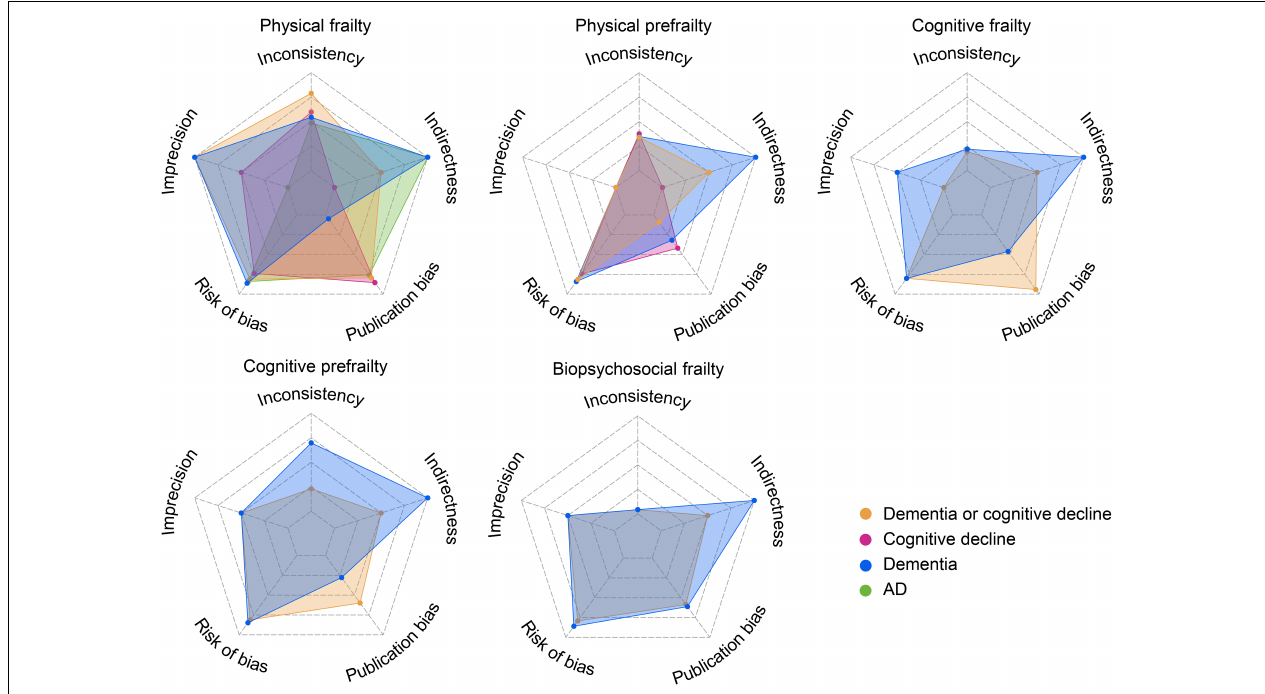
FIGURE 3 | Credibility of meta-analyses results (for more details see Supplementary Table 4 ). The credibility improved with the increased area of the radar map.